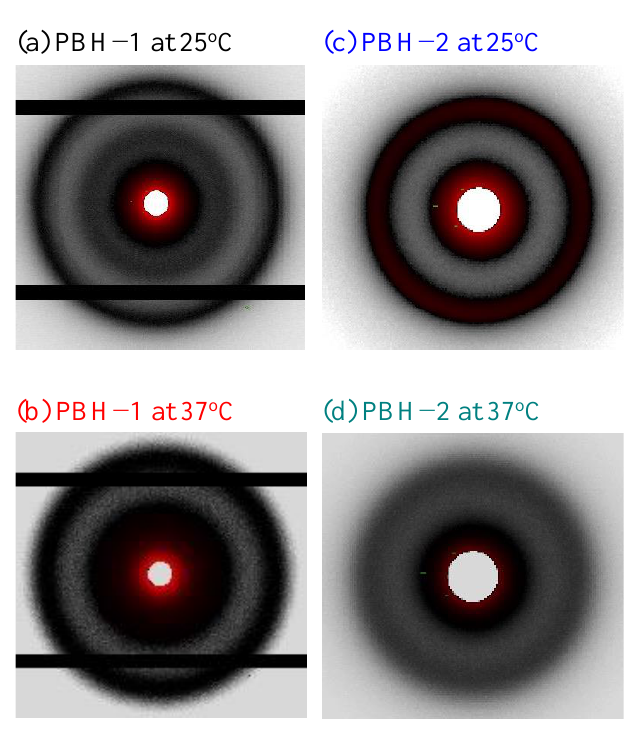
Figure 2. SAXS 1D profiles (offset for clarity, arbitrary intensity units) of the pluronic biomedical hydrogels at 25 °C.